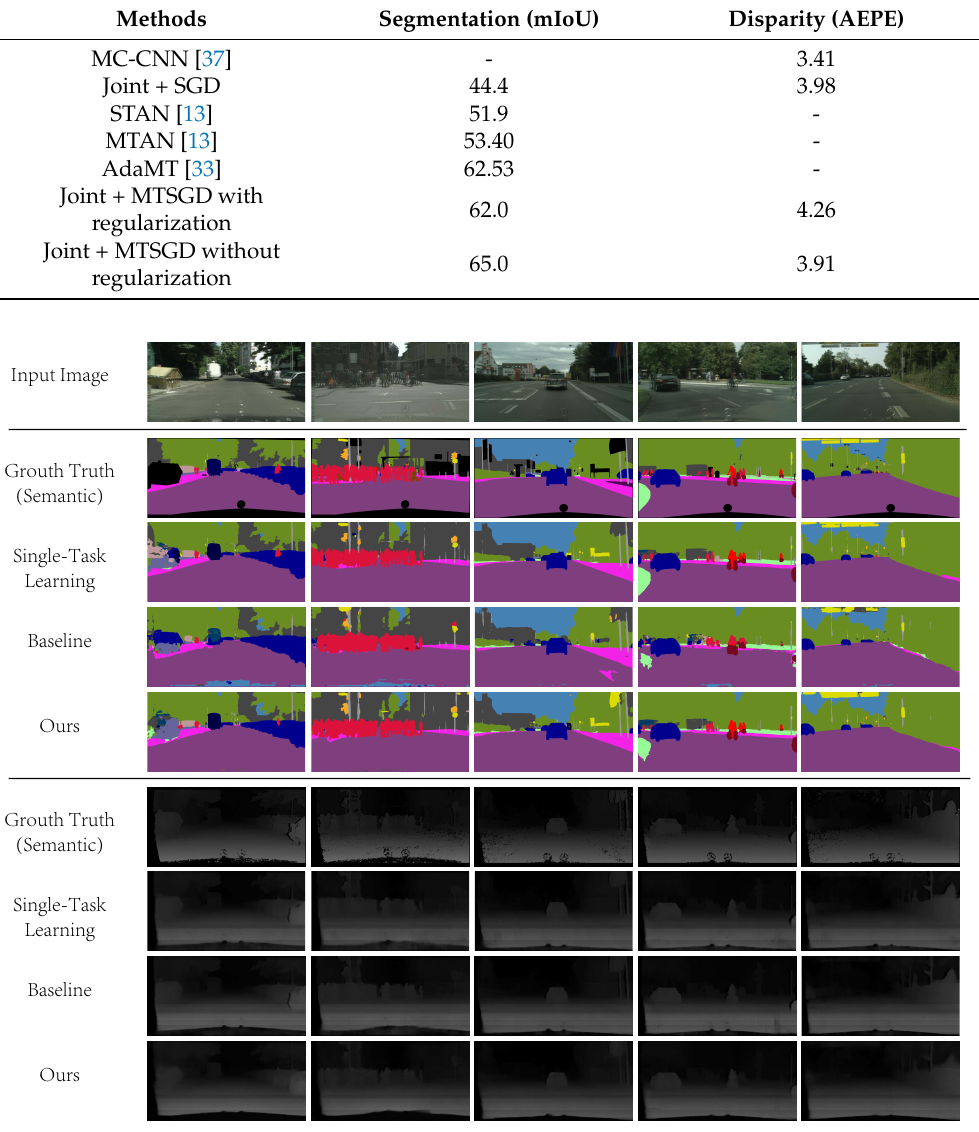
Figure 6. Visual improvement on Cityscapes